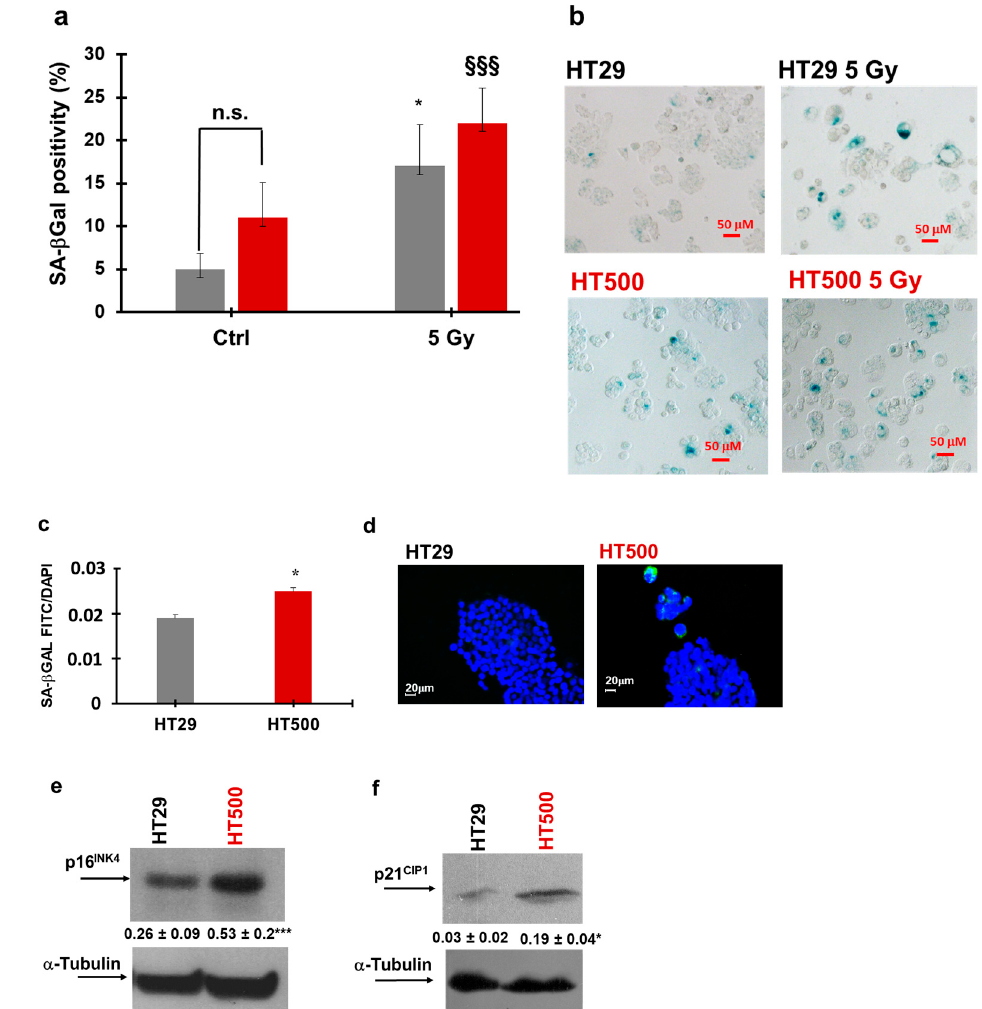
Figure 7. Senescence measurements in HT29 and HT500 cell lines. SA- β Gal staining in HT29 and HT500 cells before and after irradiation (5 Gy) were quantified (panel a ) and microscopically visu- alized (panel b ). The results of a different protocol that employed C 12 FDG staining were also quan- tified (panel c ), and representative images were reproduced ( d ). Bar graphs represent the mean ± SD of two independent experiments. Symbols indicate significance: * p < 0.05 for untreated HT29 vs. irradiated HT29 (grey bars); §§§ p ≤ 0.001 for HT500 before and after irradiation (dark red bars) One- way ANOVA with Bonferroni’s multiple comparisons test was used. The immunoblots report the basal expression of p16 INK4 (panel e ) and p21 CIP1 (panel f ) in HT29 and HT500 cells. Numbers be- tween panels indicate densitometric analysis ± SD of two independent experiments. Symbols indi- cate significance with * p < 0.05 and *** p < 0.001 (T-Test Student).